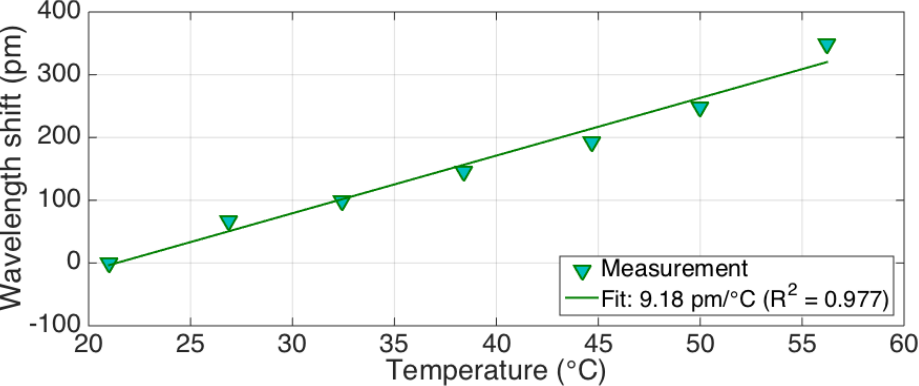
Figure 3. Calibration of the temperature coefficient of the optical fibers used for sensing.